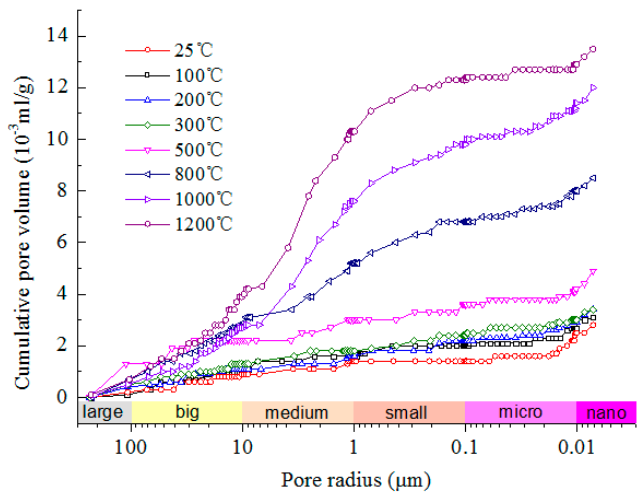
Figure 8. Relationship between cumulative pore volume and pore radius in granite samples heat-treated at different temperatures.